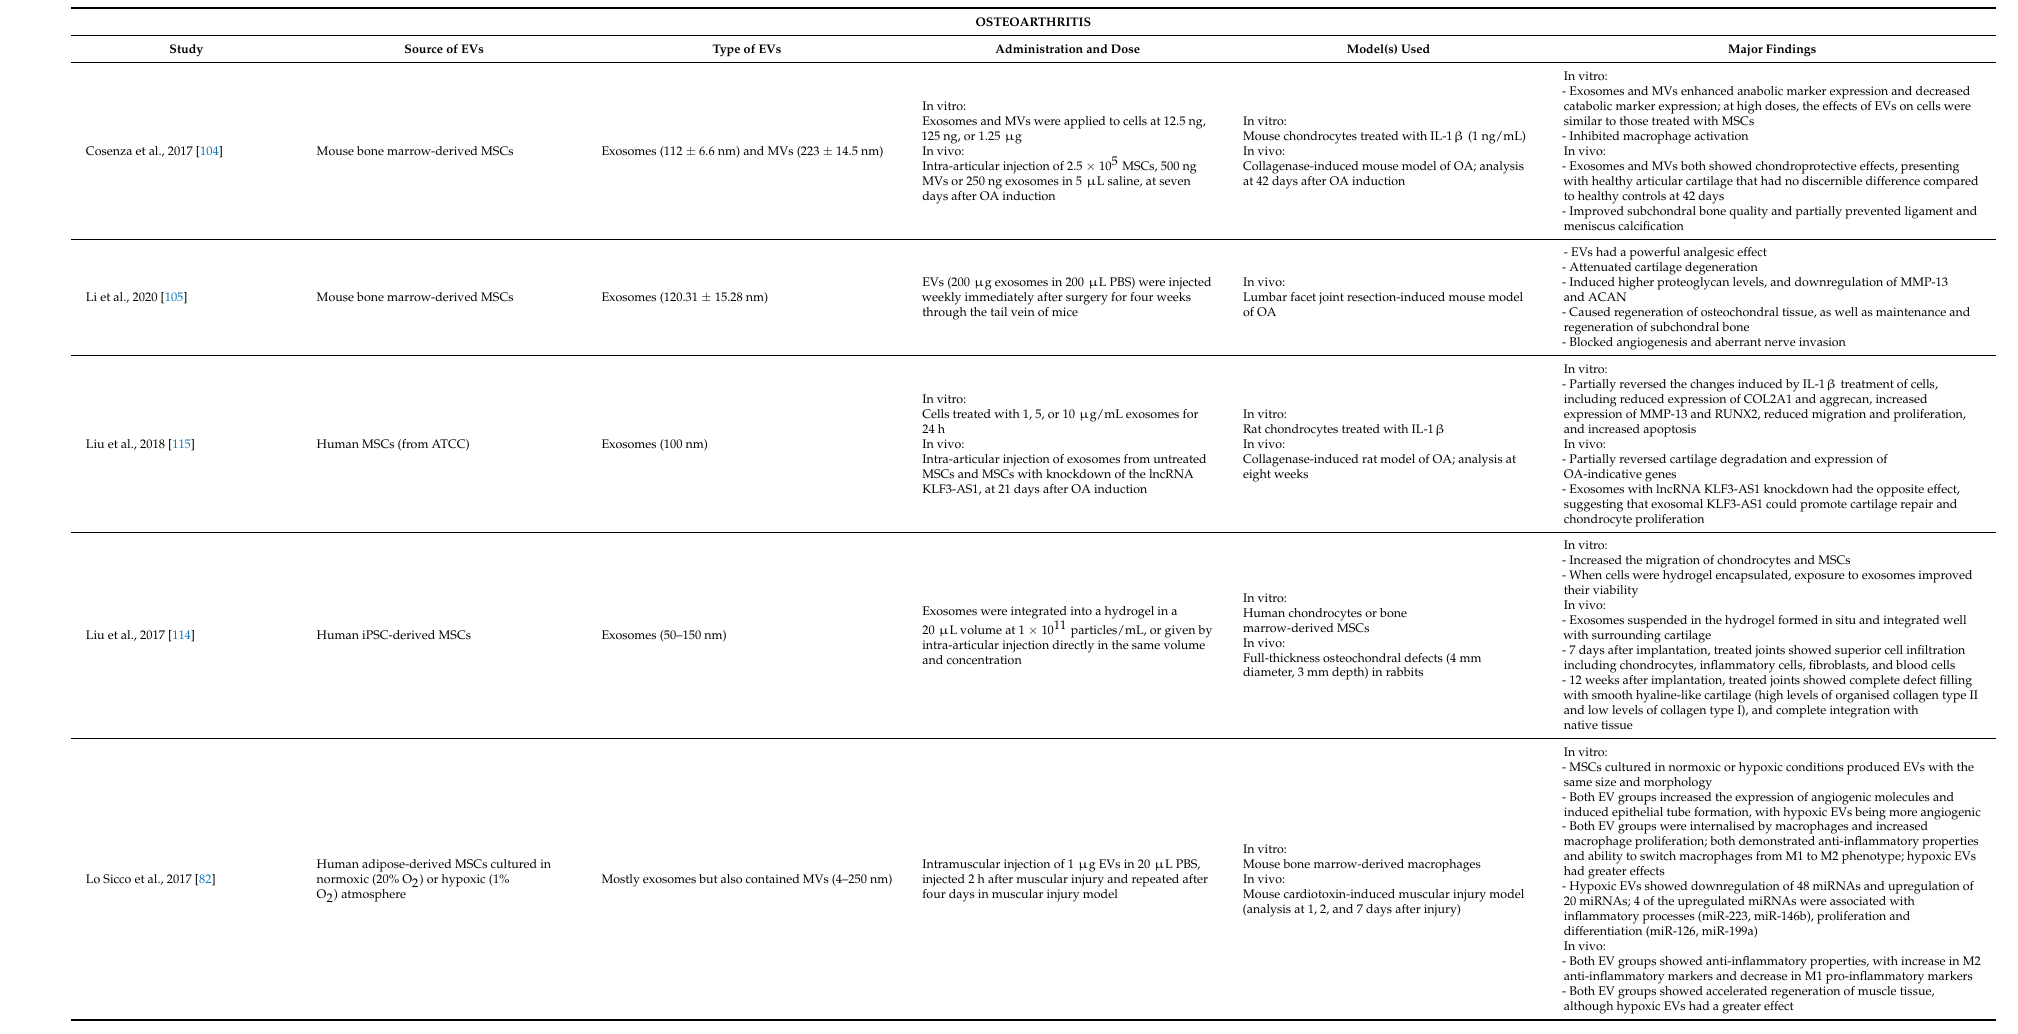
Table 1. Current evidence of the therapeutic effects of EVs in a range of inflammation-related